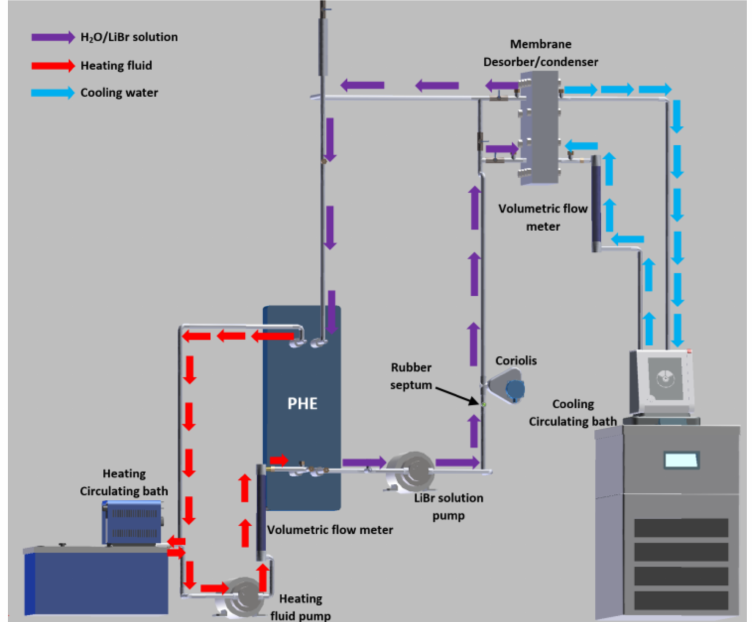
Figure 3. Schematic diagram of the experimental setup.